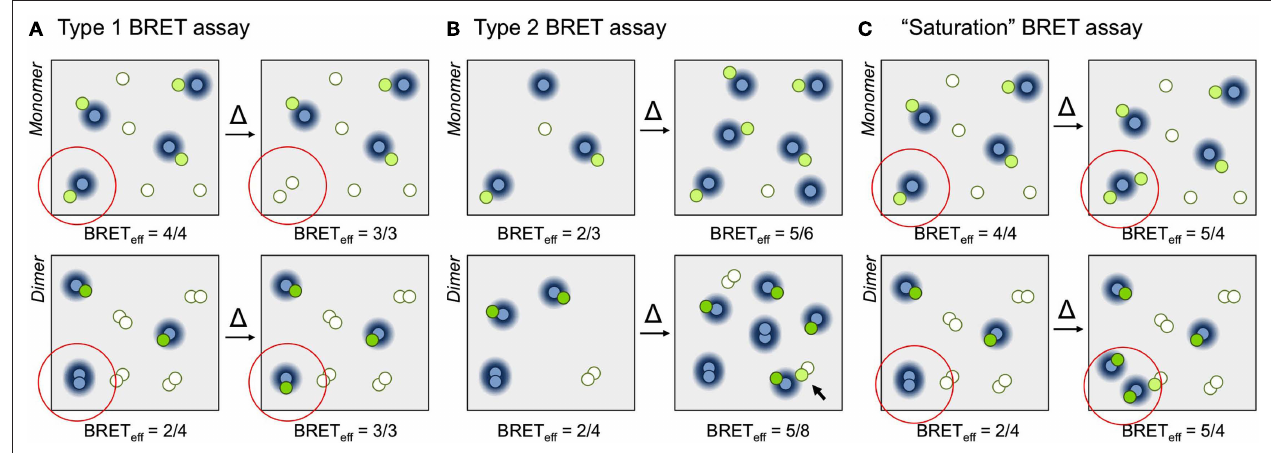
contribute to increases in BRET (in reality, of course, these contributions will eff be significantly smaller than the effects of dimerization). (C) In the “saturation” BRET assay, the acceptor/donor ratio is increased by keeping donor numbers constant and increasing the numbers of acceptors. In the examples shown, is eff BRET for monomers (top) and dimers (bottom) both increase upon addition of eff one or two extra acceptors, respectively (from 4/4/ to 5/4 for the monomer, is eff and from 2/4 to 5/4 for the dimer). This is due to the increased random interactions of monomers, and increased formation and random interactions of dimers. We expect assays in which BRET always increases to be more eff easily misinterpreted than assays in which changes in BRET vary eff systematically with receptor stoichiometry.Fluorescing and non-fluorescing acceptor molecules are shown as green and white circles, respectively, and donors as blue circles. The BRET-permissible area surrounding donors is represented as a blue